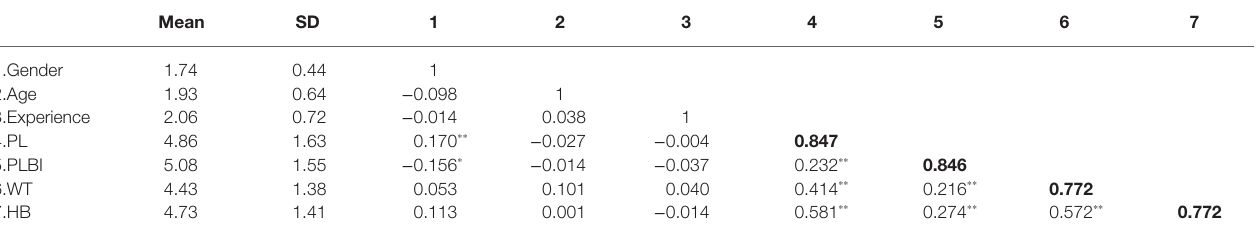
TABLE 2 | Means, SD, and correlations